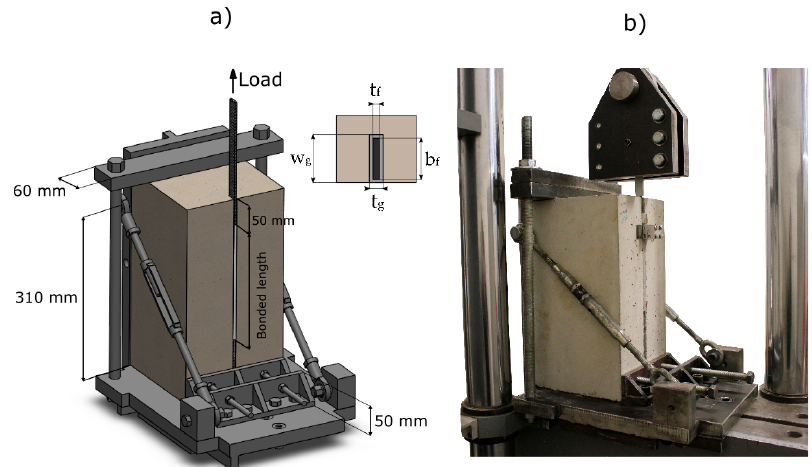
Figure 9. ( a ) scheme of the set-up for the pull-out single shear test, and ( b ) picture of the tests. Materials 2020 , 13 , x FOR PEER REVIEW Figure 9. (a) scheme of the set-up for the pull-out single shear test, and (b) picture of the tests.